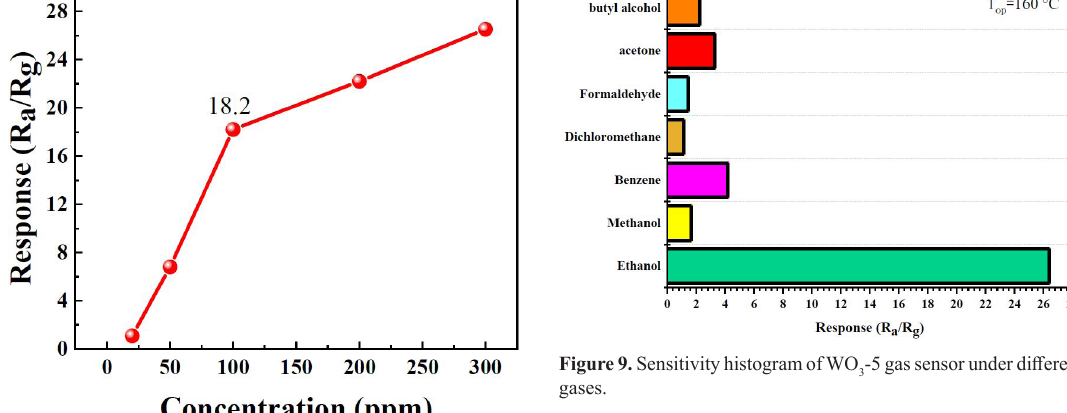
Figure 9. Sensitivity histogram of WO